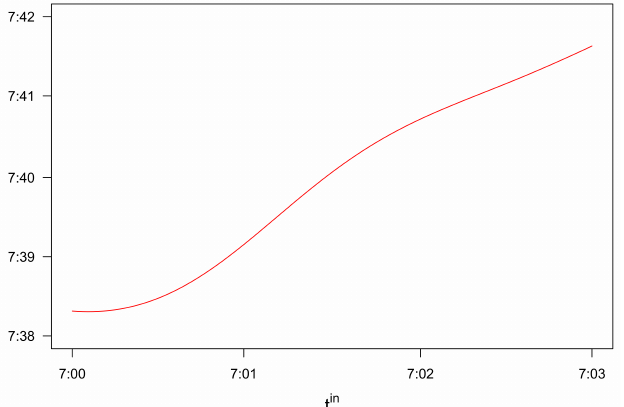
Figure 9. Curve of conditional means of t out conditionally on t in .